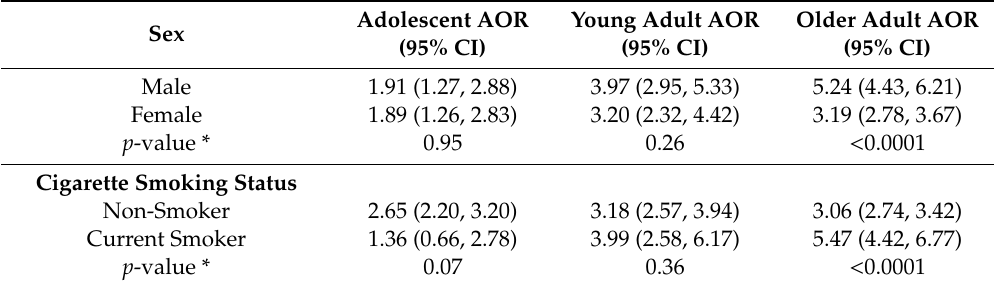
Table 4. Estimated odds of exposure in each age group by sex and cigarette smoking status.